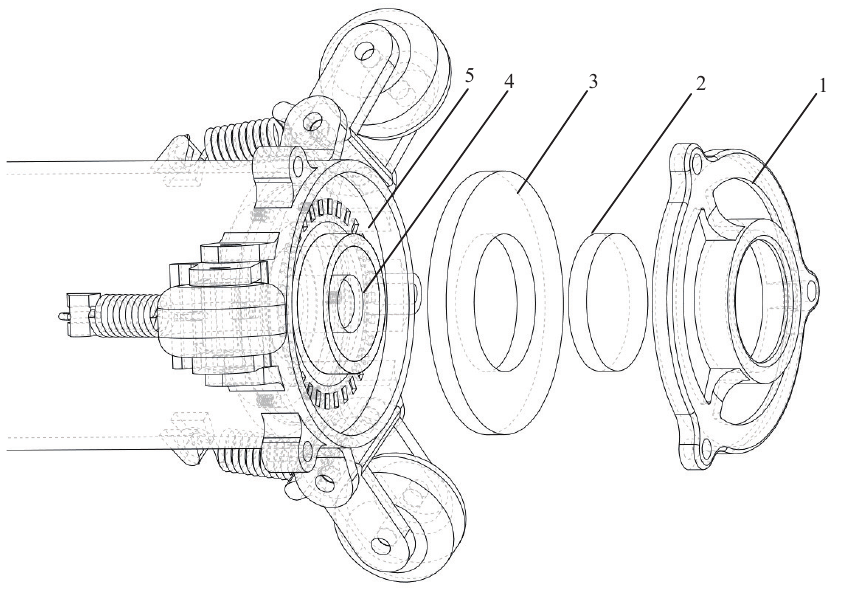
Figure 4. Structure of the camera unit; (1) fixed cover, (2) protective glass of camera, (3) protective glass of LED, (4) camera, and (5) LED light